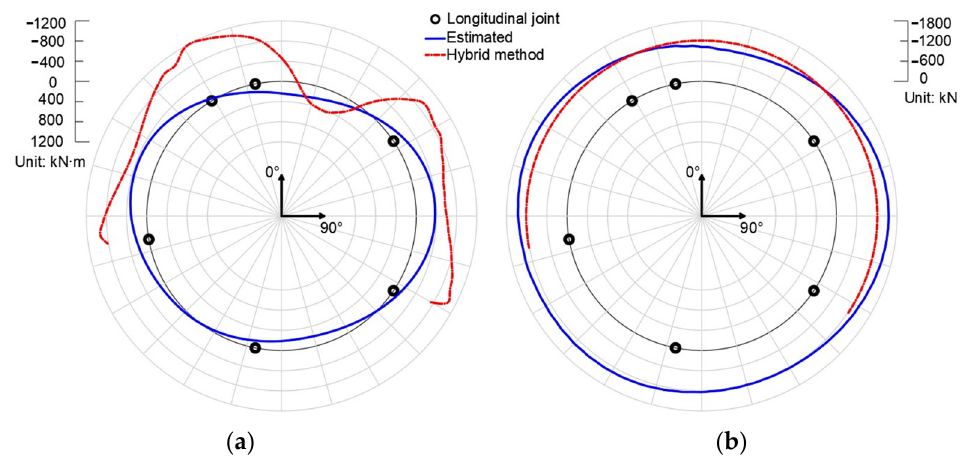
Figure 14. The results of bending moment ( a ) and axial force ( b ) of hybrid solution on a real segmental lining ring.